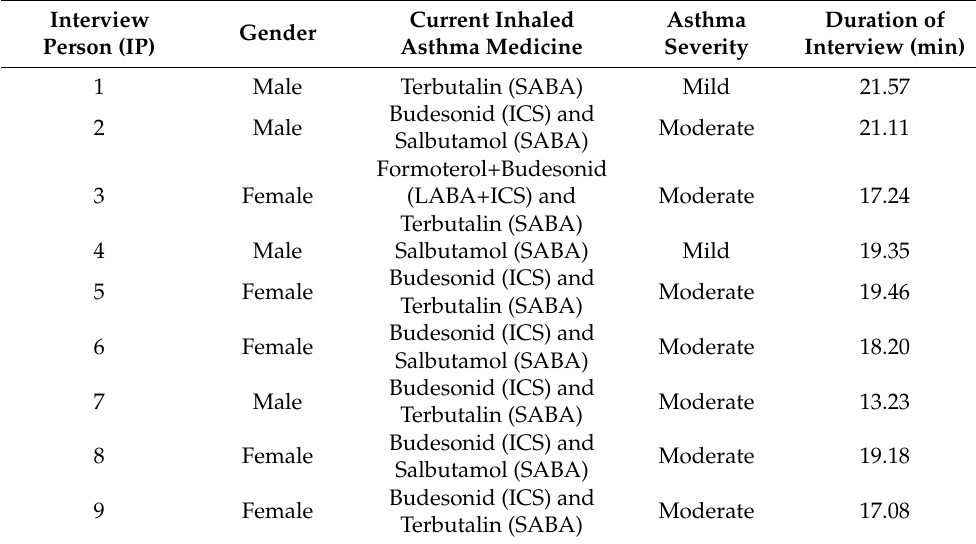
Table 2. An overview of the characteristics of the interviewees.